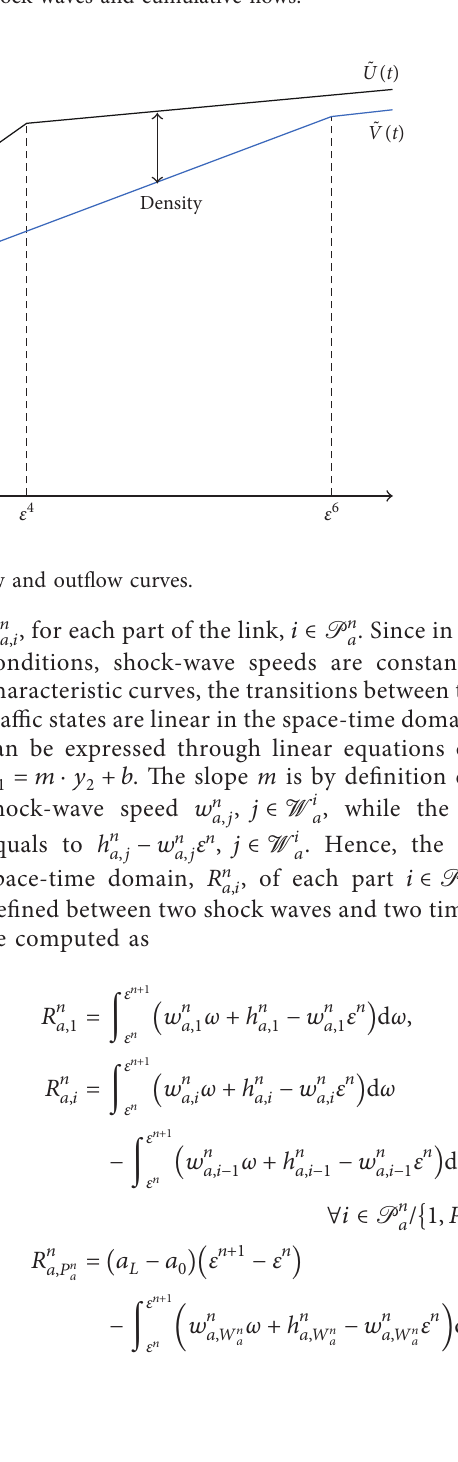
Figure 9: Spatiotemporal evolution of shock waves and cumulative flows.